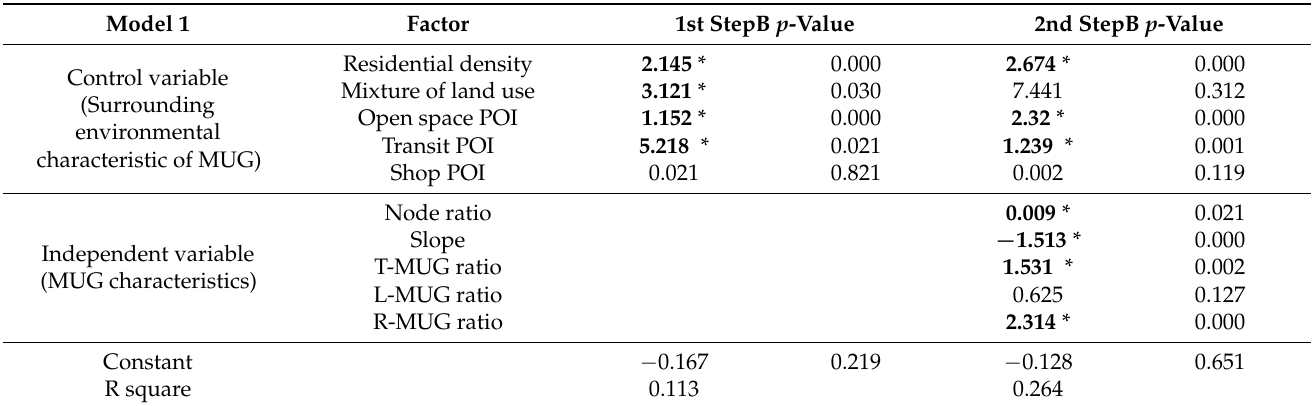
Table 6. Linear regression model of PA